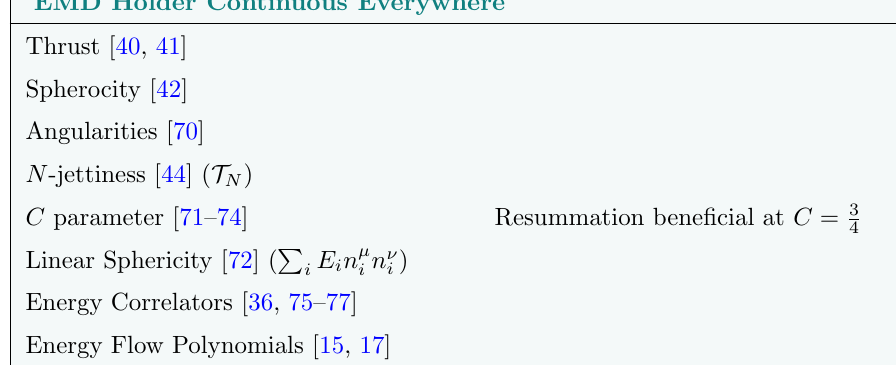
Table 3 . Examples of well-known collider observables, along with their classi(cid:12)cation according to (cid:12)gure 2. The observables satisfy the conditions of all bold-faced categories above them in the table. Note that via our classi(cid:12)cation, Sudakov safe observables are IRC safe, since the discontinuities appear on N -particle manifolds which are negligible sets in the full space.